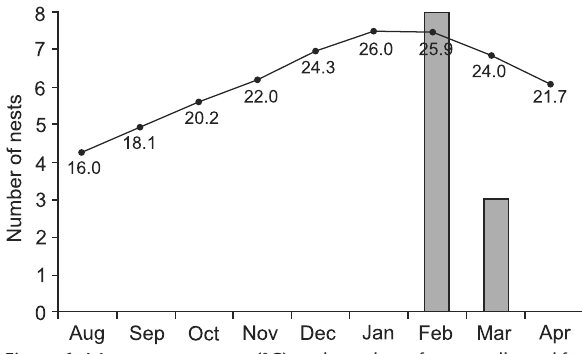
Figure 1. Mean temperature (°C) and number of nests collected for each month from August 2013 to April 2014.